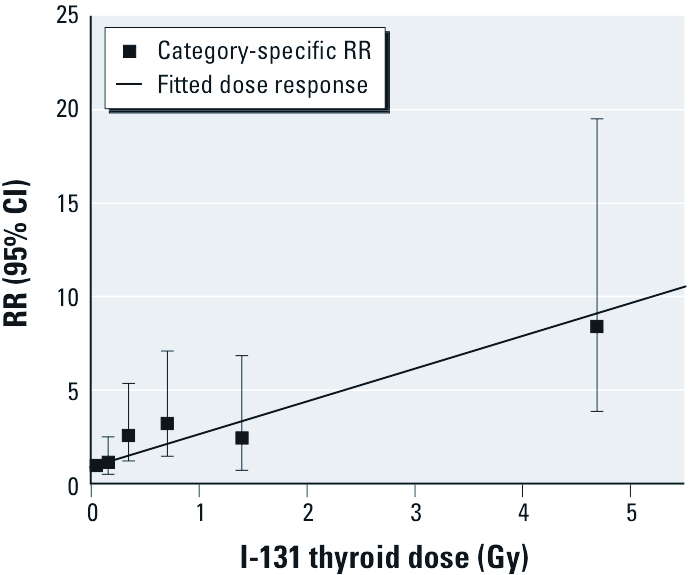
Dose–response relationship between incident thyroid cancers and
I‑131 dose estimates in a cohort study of thyroid cancer and other thyroid diseases
after the Chornobyl accident in Ukraine. The solid line represents fitted RRs based
on the linear ERR model; data points and error bars represent category-specific RRs
and 95% CIs for mean I‑131 dose per category. The fitted linear dose response was
adjusted to pass through the lowest I‑131 category. The ERR was adjusted for sex,
oblast of residence at the first screening examination, and continuous attained
age.